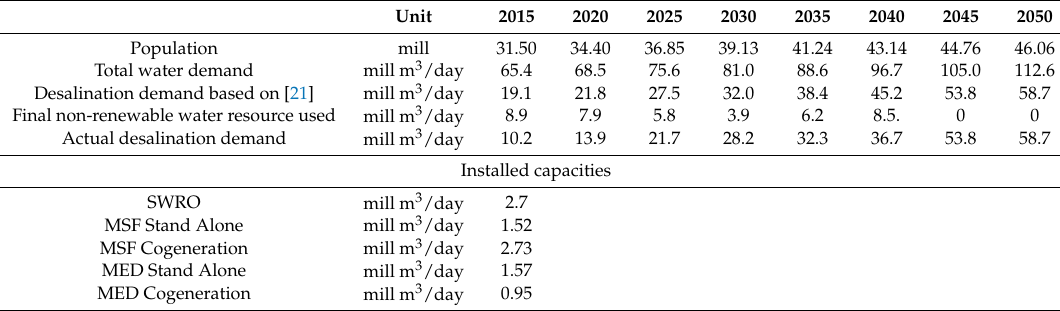
Table 8. Desalination capacities required to meet KSA’s increasing total water